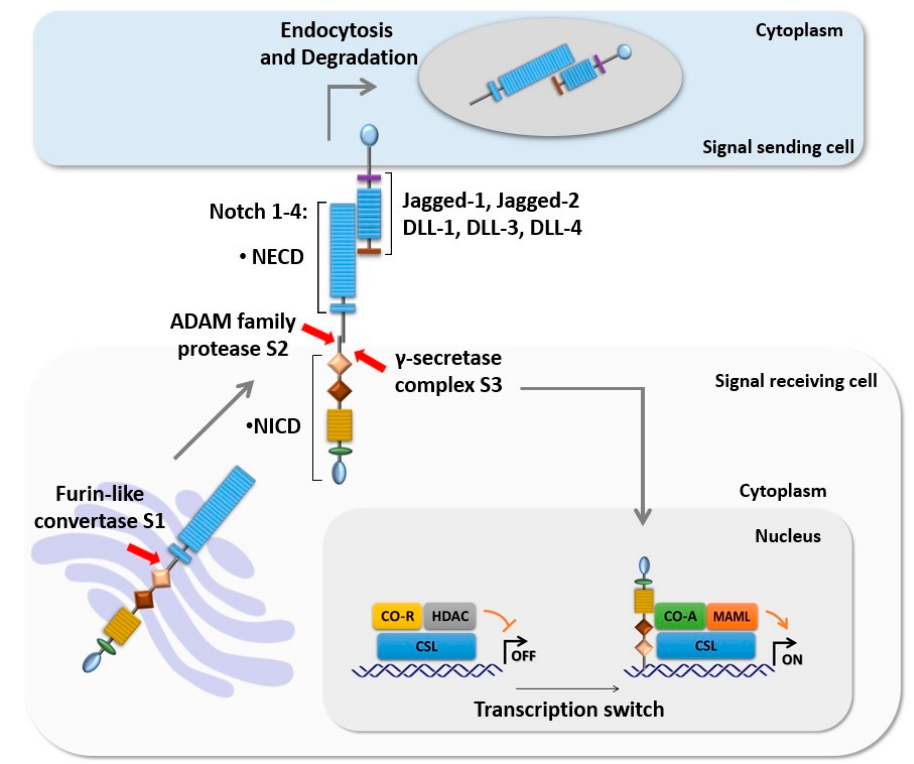
Figure 1. Intracellular Notch signaling cascade. The core components of Notch signaling are Notch ligands (DLL-1, 3, and 4 and Jagged-1 and 2), Notch receptors (Notch 1–4), and the CSL transcription factor. The newly synthesized Notch receptor is processed in the Golgi apparatus by furin-like convertase at S1. Activation of Notch by its ligand initiates two proteolytic cleavages of Notch at S2 and S3 respectively. S3 cleavage results in translocation of NICD to the nucleus where it mediates transcription switch through displaces of CSL CO-R and recruits CSL CO-A such as MAML, promoting the transcription of the target